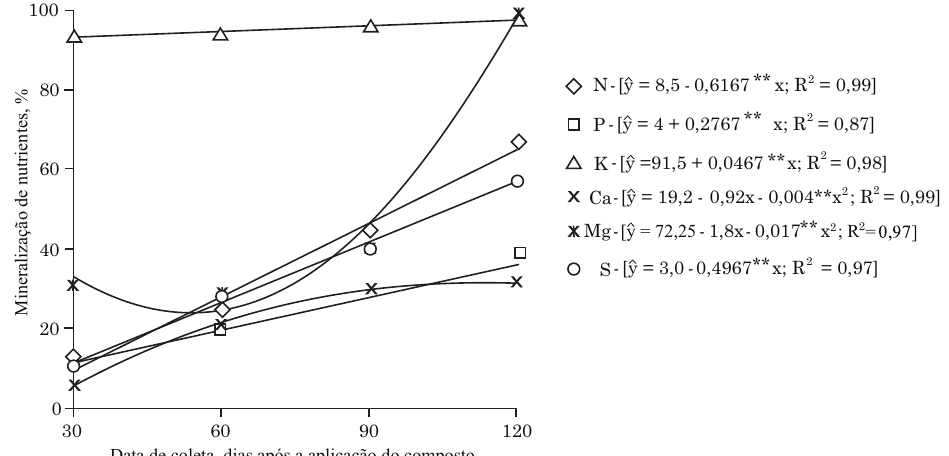
Figura 3. Média da taxa de mineralização de macronutrientes presentes nas doses de composto do lodo de esgoto em função dos dias após a disposição dos saquinhos sobre a superfície do